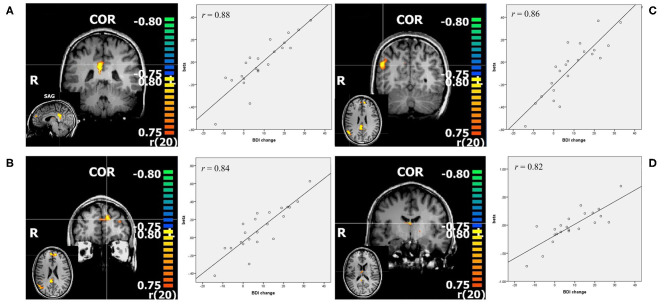
Resulting regions of correlation analysis with change in BDI in contrast positive>neutral. The color bars represent r values, p < 0.00005. (A) PCC: posterior cingulate cortex; (B) mFG: middle frontal gyrus; (C) mTG: middle temporal gyrus; (D) thalamus, all shown in coronal slice, with sagittal or transverse slice shown in small. Additionally scatterplots of the depicted regions beta values and change in BDI are shown, as well as r = Pearson's correlation coefficient.